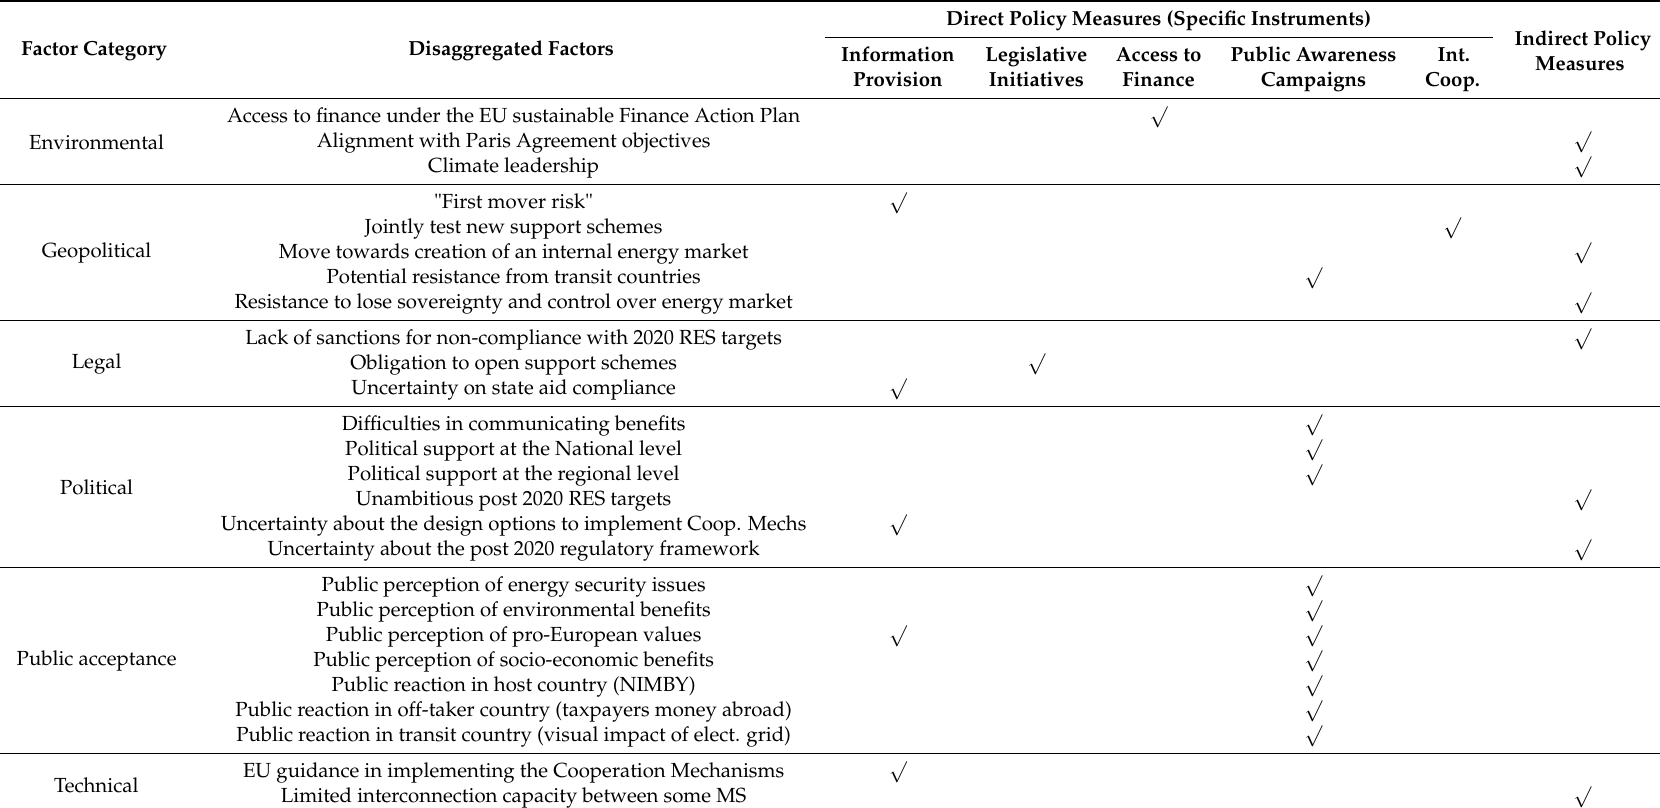
Table 3. Relevant policy interventions for each disaggregated factor. Source: own